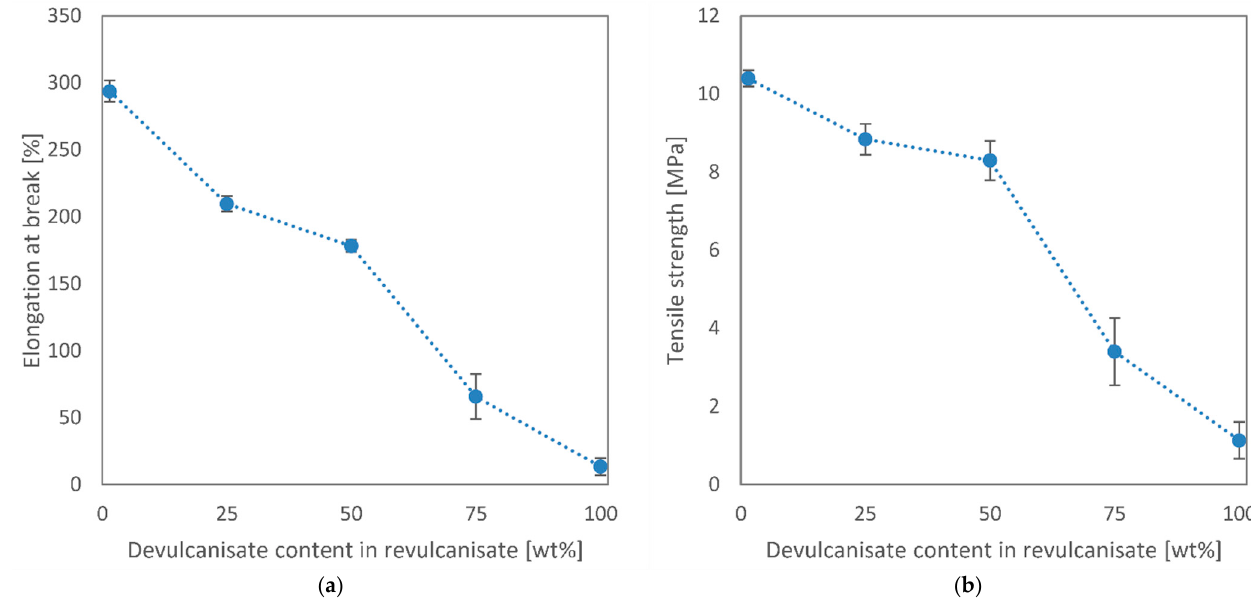
Figure 5. Tensile properties of the revulcanisates plotted against their recycled contents: ( a ) elongation at break vs. devulcanisate content; ( b ) tensile strength vs. devulcanisate content.